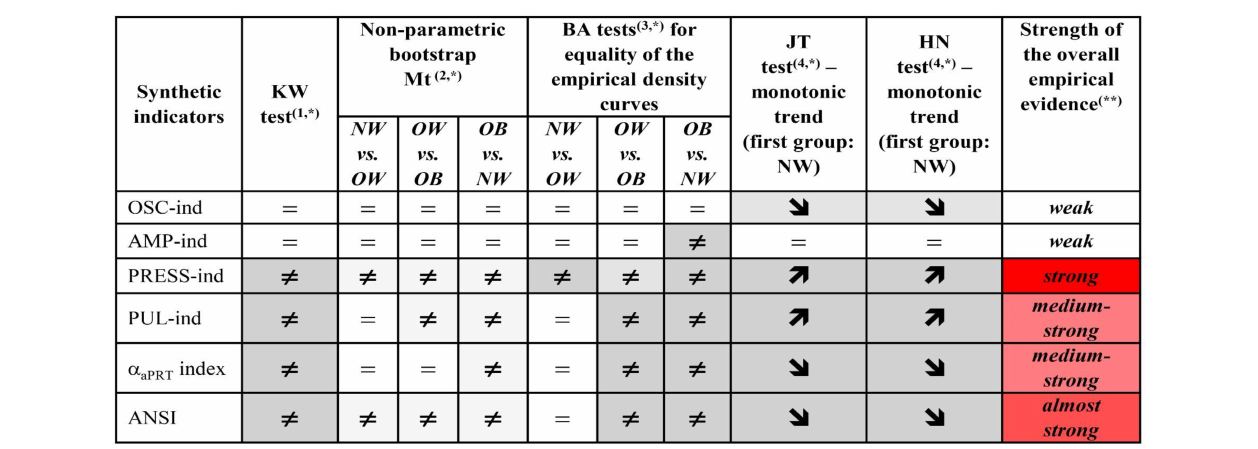
FIGURE 6 | Synoptic figure summing up the results of the Kruskal–Wallis (KW) test, non-parametric bootstrap median test (Mt), Bowman–Azzalini (BA) test, Jonckheere–Terpstra (JT), and Hettmansperger–Norton (HN) tests for ordered monotonic alternatives. Let θ g be the effect of BMI group g on the synthetic indicator Y , with g = NW, OW, OB. For each test, the null and alternative hypotheses along with symbols in the above cells, indicating either acceptance or rejection of the null hypothesis, are: ( 1 ) KW test: H 0 : θ NW = θ OW = θ OB (symbol=) against: H 1 : θ g (cid:54)= θ g (cid:48) (symbol (cid:54)= ) for at least one pair of groups ( g , g (cid:48) ), with g (cid:54)= g (cid:48) ; ( 2 ) Median test (Mt): see the legend below Table 6 , with H 0 : Med g ( Y ) = Med g (cid:48) ( Y ) (symbol=) and H 1 : Med g ( Y ) (cid:54)= Med g (cid:48) ( Y ) (symbol (cid:54)= ), with g (cid:54)= g (cid:48) ; ( 3 ) BA test: see the legend below Figure 5 , with H